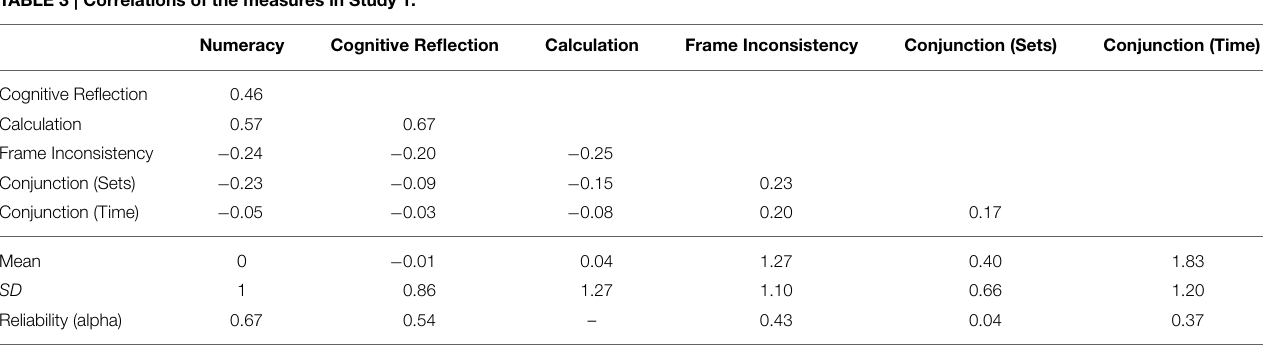
TABLE 3 | Correlations of the measures in Study